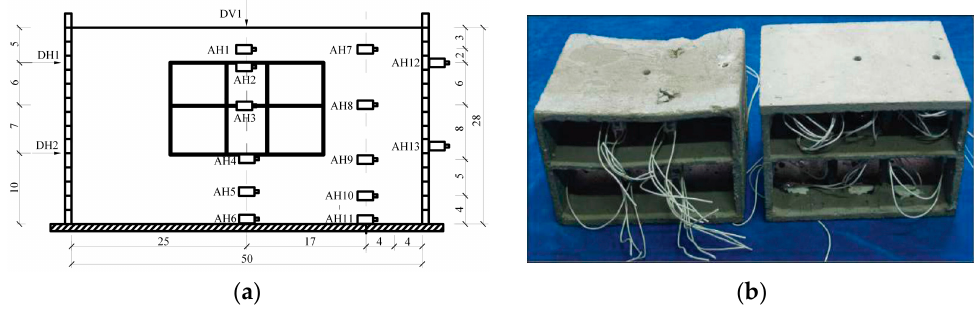
Figure 5. Installed accelerometers and displacement transducers. ( a ) Layout in the test model; ( b ) snapshot of the actual specimen with installed devices.